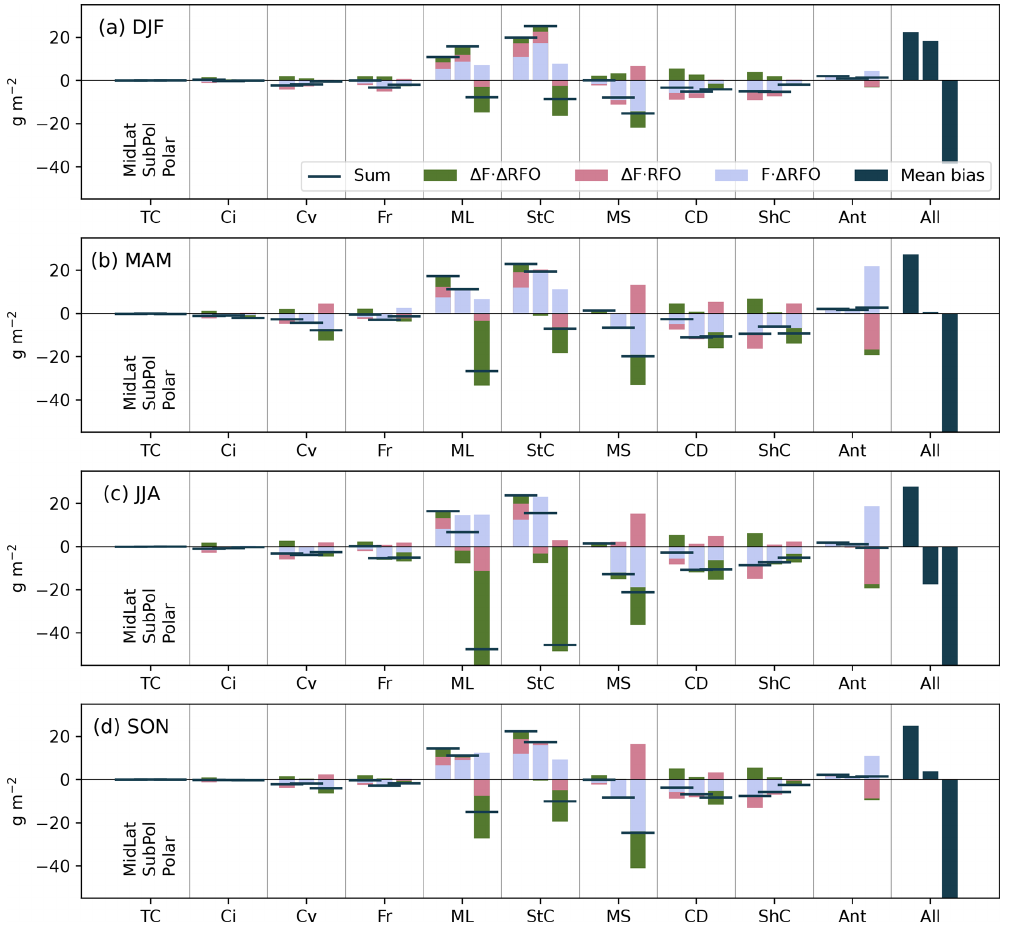
Figure A3. The decomposed mean biases in the LWP (gm − 2 ) for each cloud regime (thin cirrus, TC; cirrus, Ci; convective, Cv; frontal, Fr; mid-level, ML; stratocumulus, StC; marine stratiform, MS; cloud decks, CD; shallow cumulus, ShC; Antarctic, Ant) over the three regions from left to right mid-latitudes, sub-polar and polar, for each season (DJF, a ; MAM, b ; JJA, c ; SON, d ). The sum of the decomposed biases is shown by the horizontal bar, while the terms of the bias decomposition (see Eq. 1) are shown in blue ( F sat r · (cid:49) RFO r ), pink ( (cid:49)F r · RFO sat r ) and green ( (cid:49)F r · (cid:49) RFO r ). On the far right of each plot is the mean radiative bias for each region/season as a